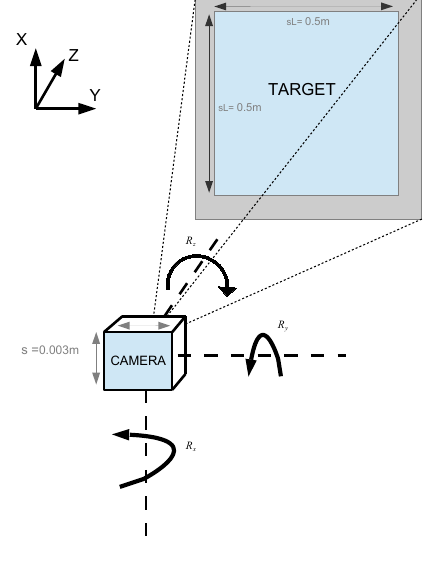
Figure 15. Camera-target.